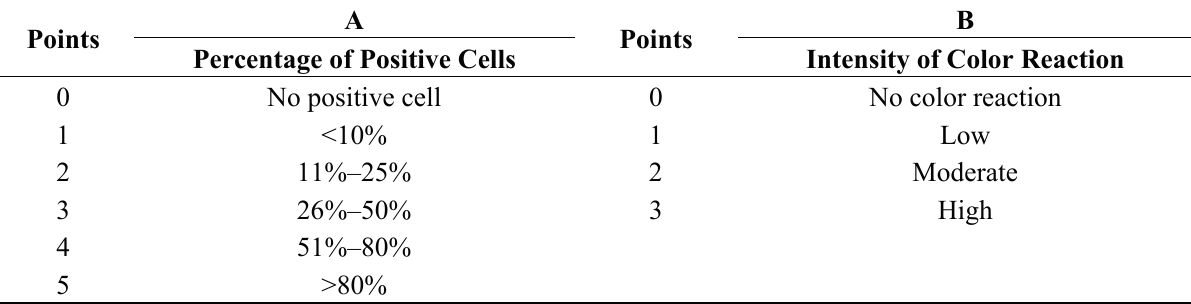
Table 3. Semiquantitative Immunoreactive Score (IRS) of Remmele and Stegner